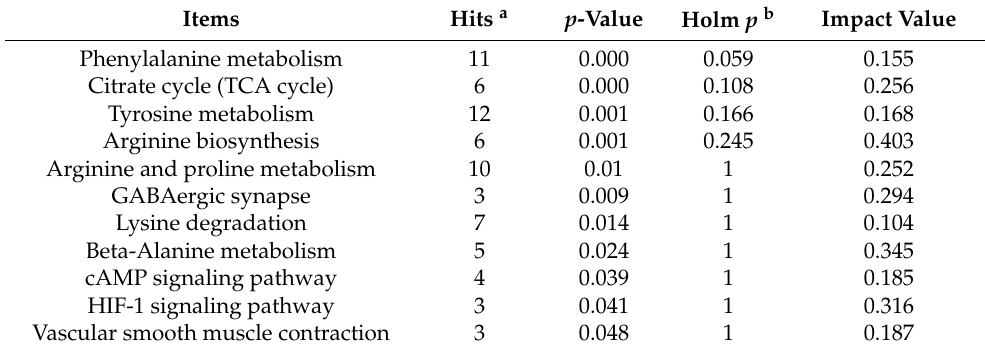
Table 6. KEGG pathway enrichment analysis of differential metabolites in yaks.